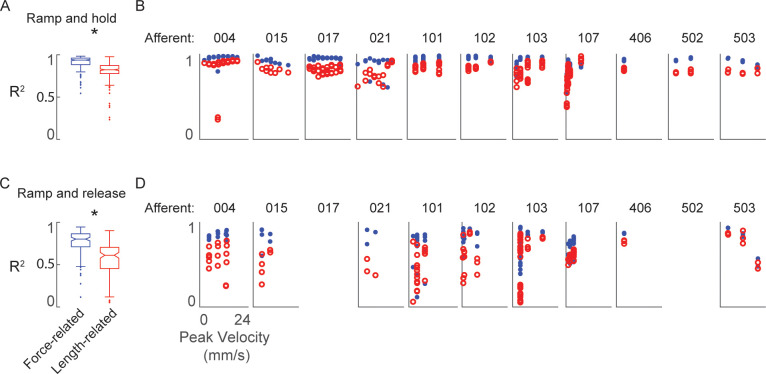
Goodness-of-fit to measured muscle spindle Ia afferent firing rates using estimated muscle fiber force and yank (blue) compared to kinematics model (red) as baseline comparison.(A) Box and whisker plots of model goodness of fit (R2) for all ramp-and-hold trials using estimated fiber force-based (blue) versus length-based (red) models. * denotes a significant difference between the model goodness of fit based on cumulative squared errors; p<0.05, one-way ANOVA. (B) R2 values for all individual trials of ramp-and-hold and within each afferent plotted versus stretch velocity for force-based (blue dots) versus length-based (red dots) models. (C–D) Same as A-B, only for repeated ramp-release trials.